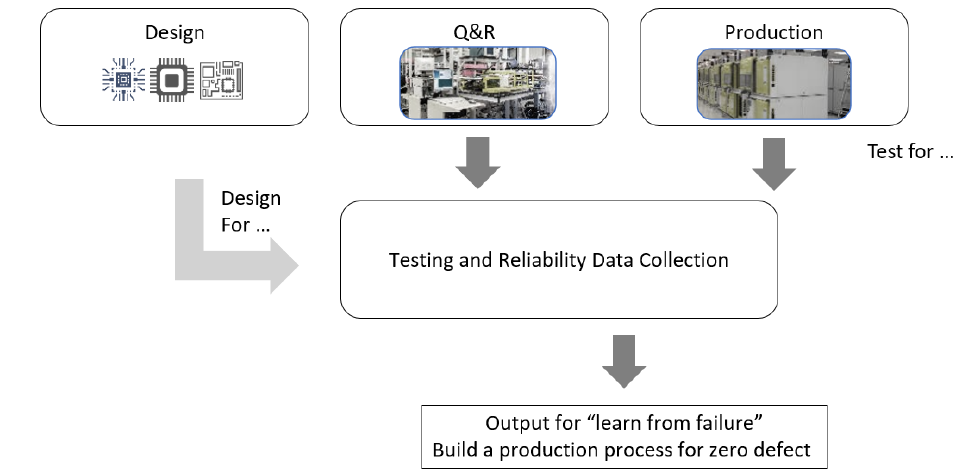
Figure 6. Test for Reliability Flow.